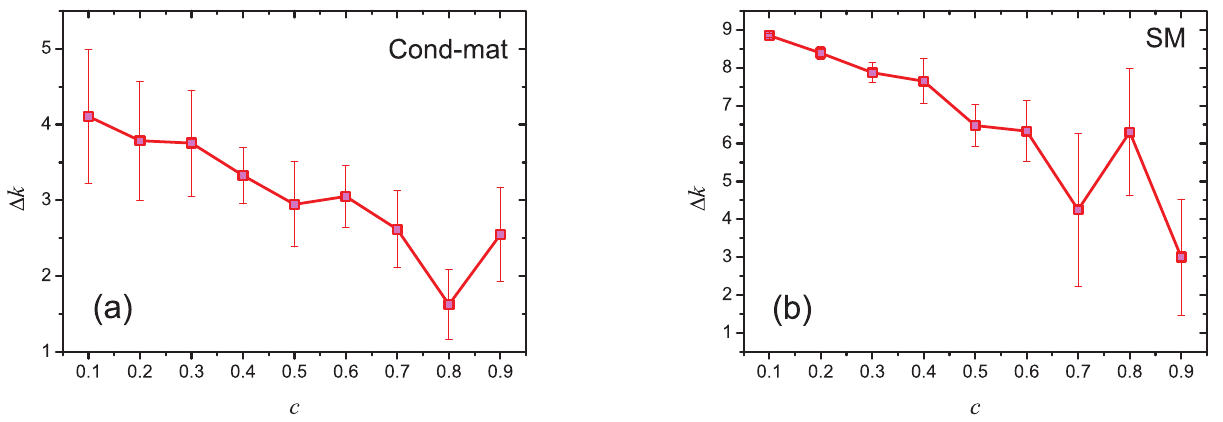
Figure 2. The increment of degree D k in the period T 1 ? T 2 of nodes with the same degree ( k ~ 5 ) but different clustering coefficients at time T 1 . D k is the average value of a bin (size=0.1) on clustering coefficient. For example, the value of D k corresponding to c ~ 0 : 1 is the average value of D k of the nodes with clustering coefficient in (0 : 05,0 : 15 (cid:1) . The error bars stand for standard errors.